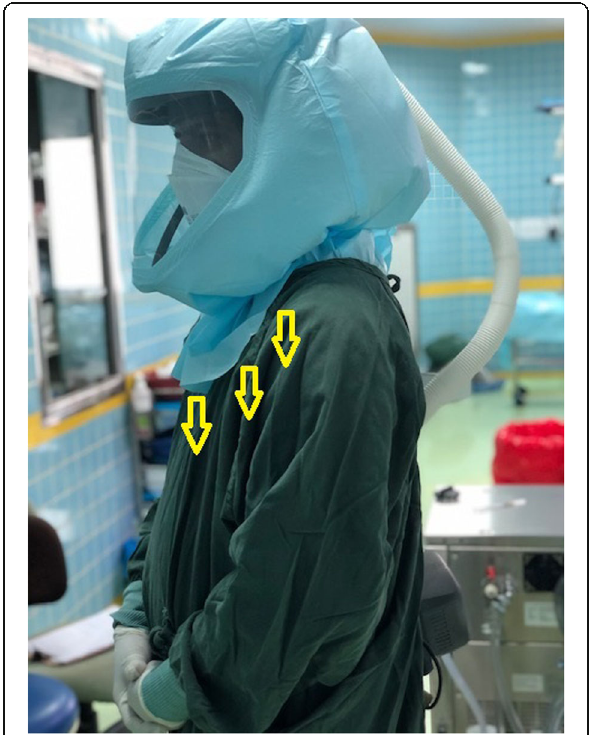
Fig. 1 An Anesthesiologist wearing a N95 FFR along with loose- fitting PAPR. The arrows indicate the direction of the exhaled air escaping under loose-fitting hood but filtered through the N95